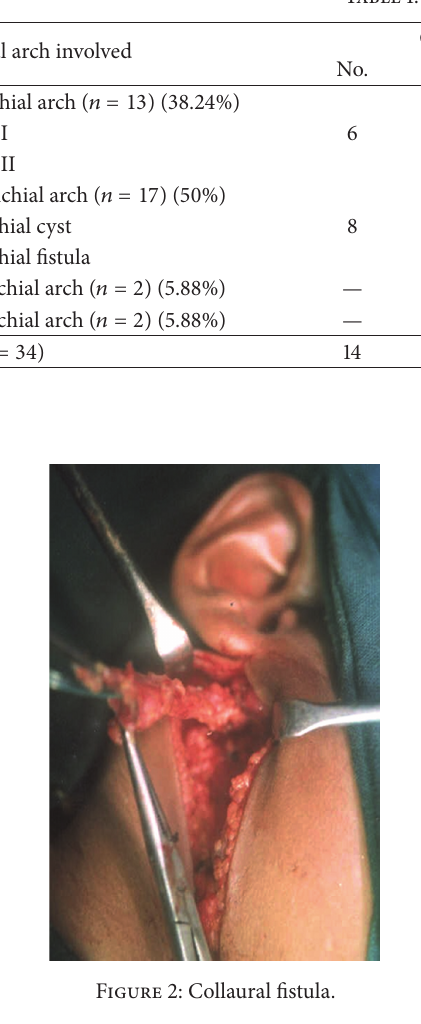
Table 1: Incidence of individual anomalies.